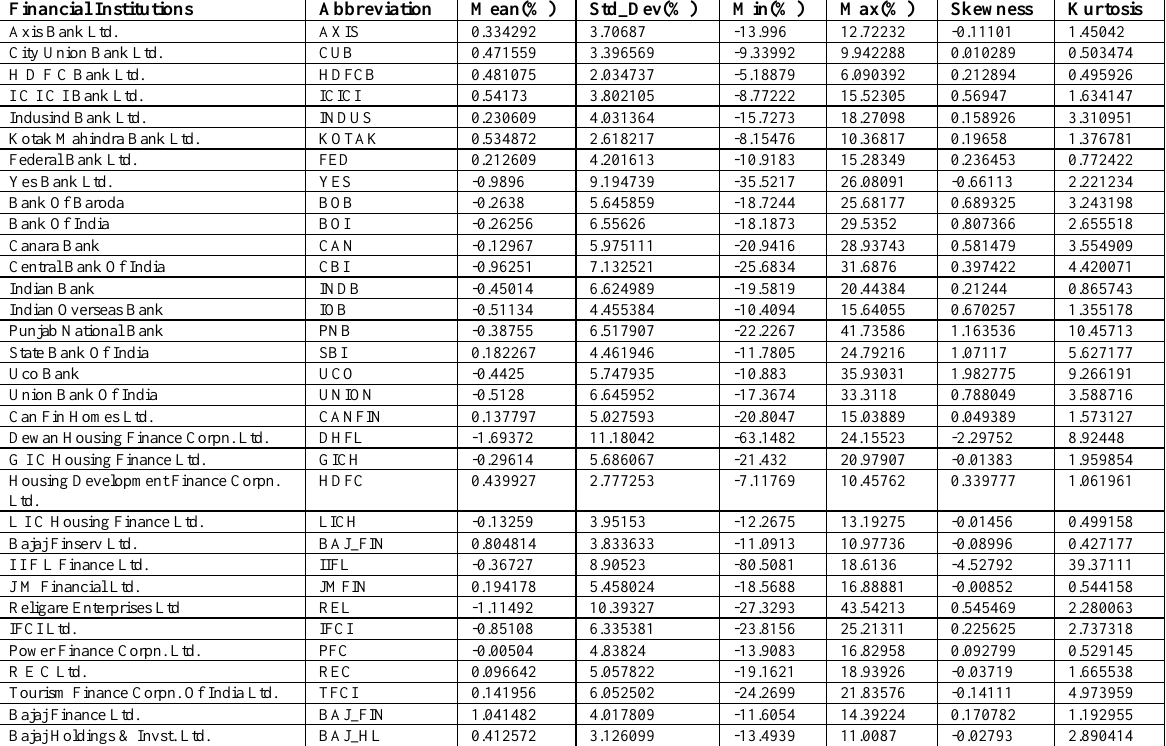
Table 2. Summary statistics of financial